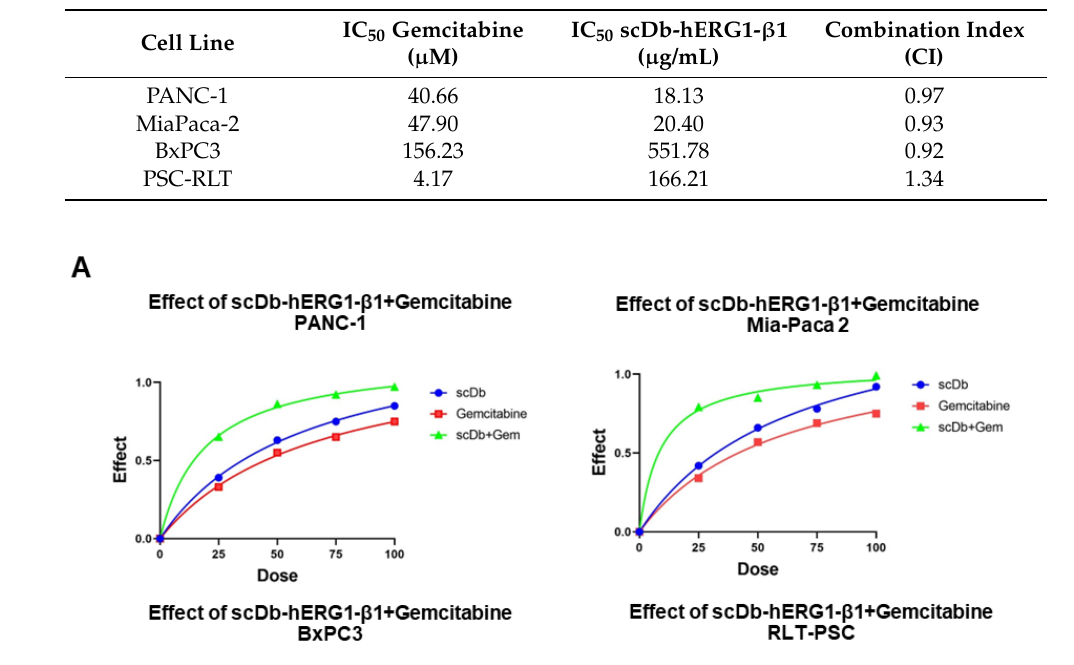
scribed above were then determined. Figure S1 shows the dose-response curves for Gem- citabine and scDb-hERG1- β 1 in PANC-1, MiaPaCa-2, BxPC3 and PSC-RLT cells. These data allowed us to determine the IC 50 values (Table 2). The e ffi cacy of Gemcitabine was high (IC 50 < 5 µM) for BxPC3, good (IC 50 ~ 40 µM) for PANC-1 and MiaPaca-2 cells, and